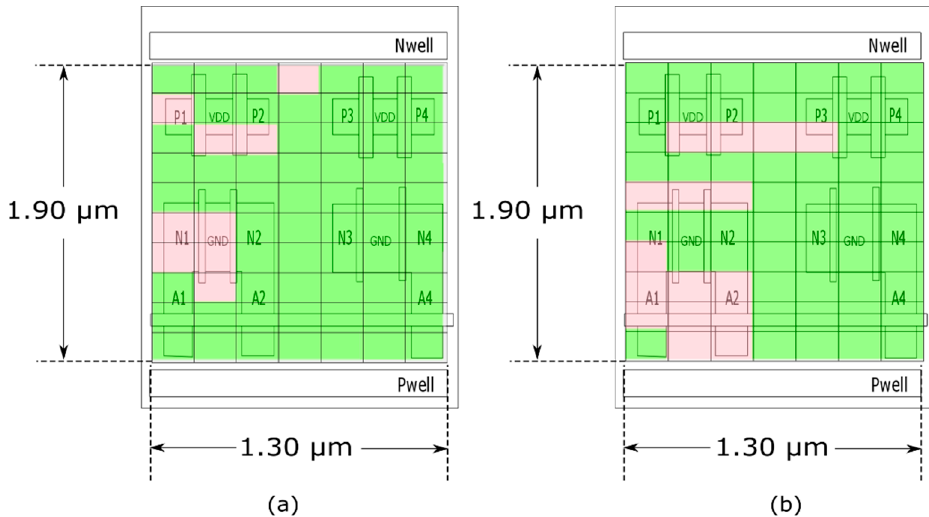
Figure 20. ( a ) Sensitivity map for Regular_11T structure with all ‘0’ stored data pattern; ( b ) sensitivity map for Regular_11T structure with ‘0/1’ pattern (laser energy: 90 pJ).